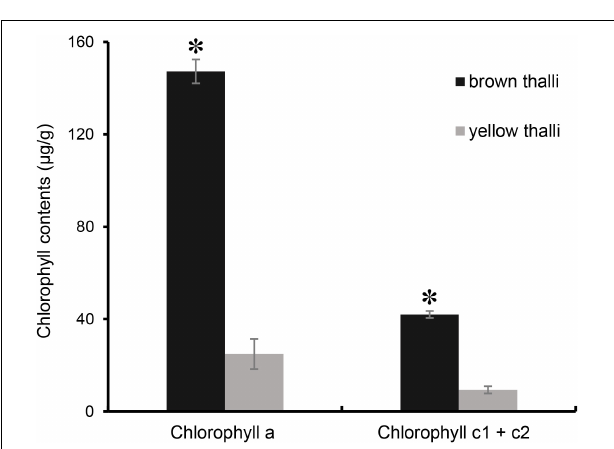
FIGURE 4 | Comparison of chlorophyll contents between brown and yellow S. horneri thalli. The error bar represented the standard deviation, the asterisk above represented the significant